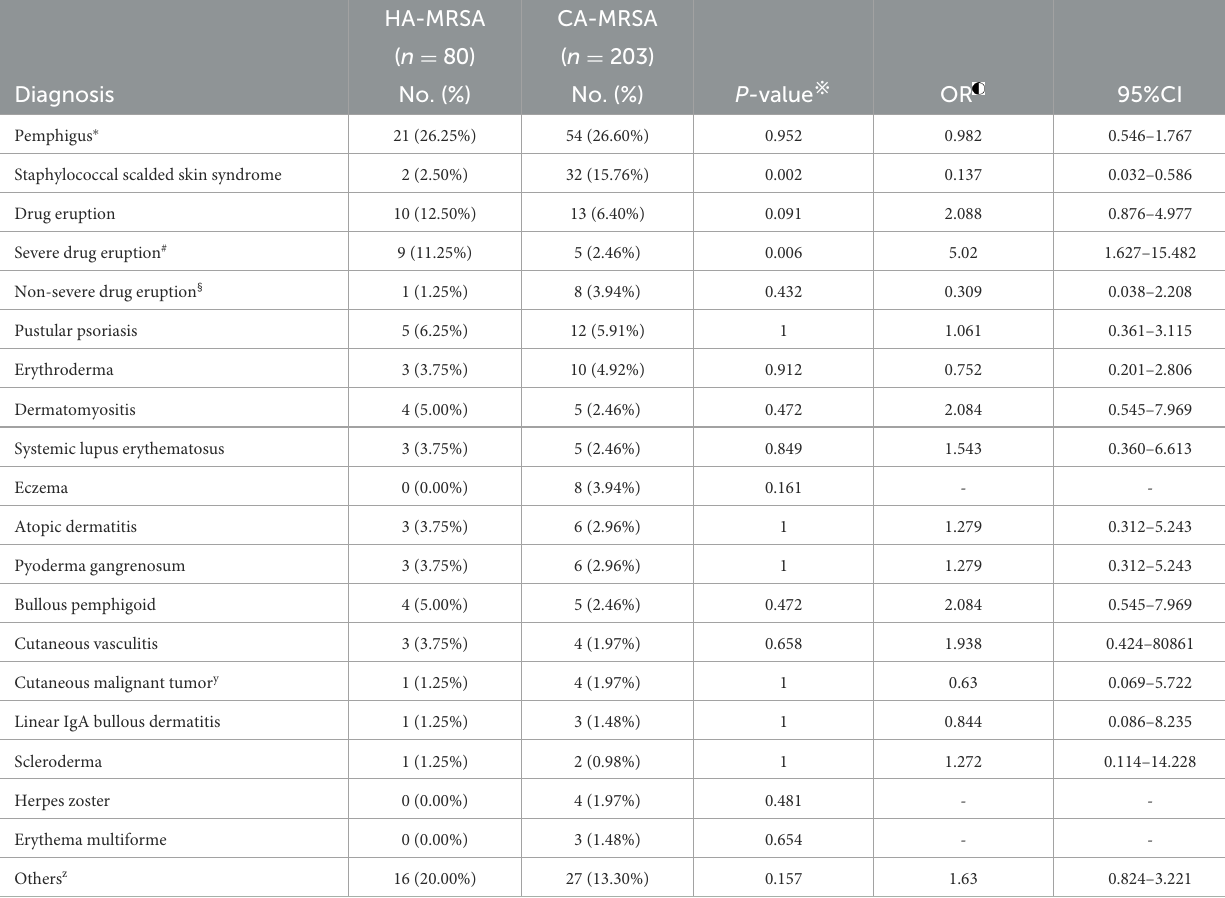
TABLE 3 Comparison of comorbidities associated with skin and soft tissue healthcare-associated methicillin-resistant S. aureus (HA-MRSA) and community-associated methicillin-resistant S. aureus (CA-MRSA) infection from January 1, 2015 to December 31,